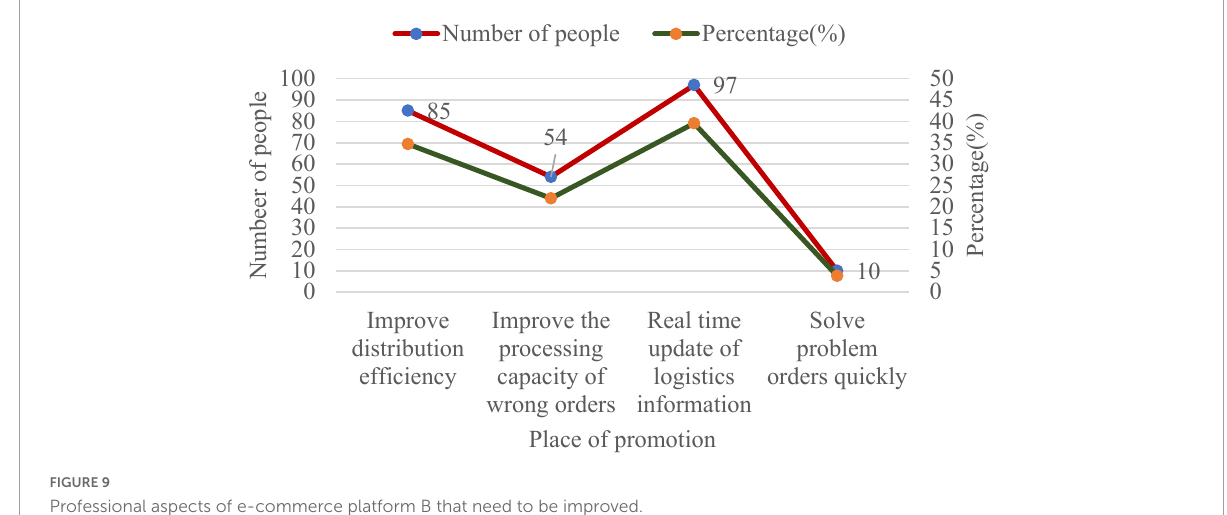
FIGURE9 Professional aspects of e-commerce platform B that need to be